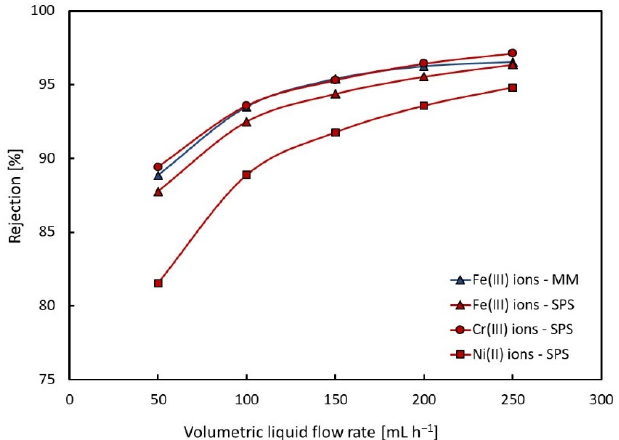
Figure 3. Dependence of rejection on volumetric liquid flow rate for model mixture (MM) and spent pickling solution (SPS).